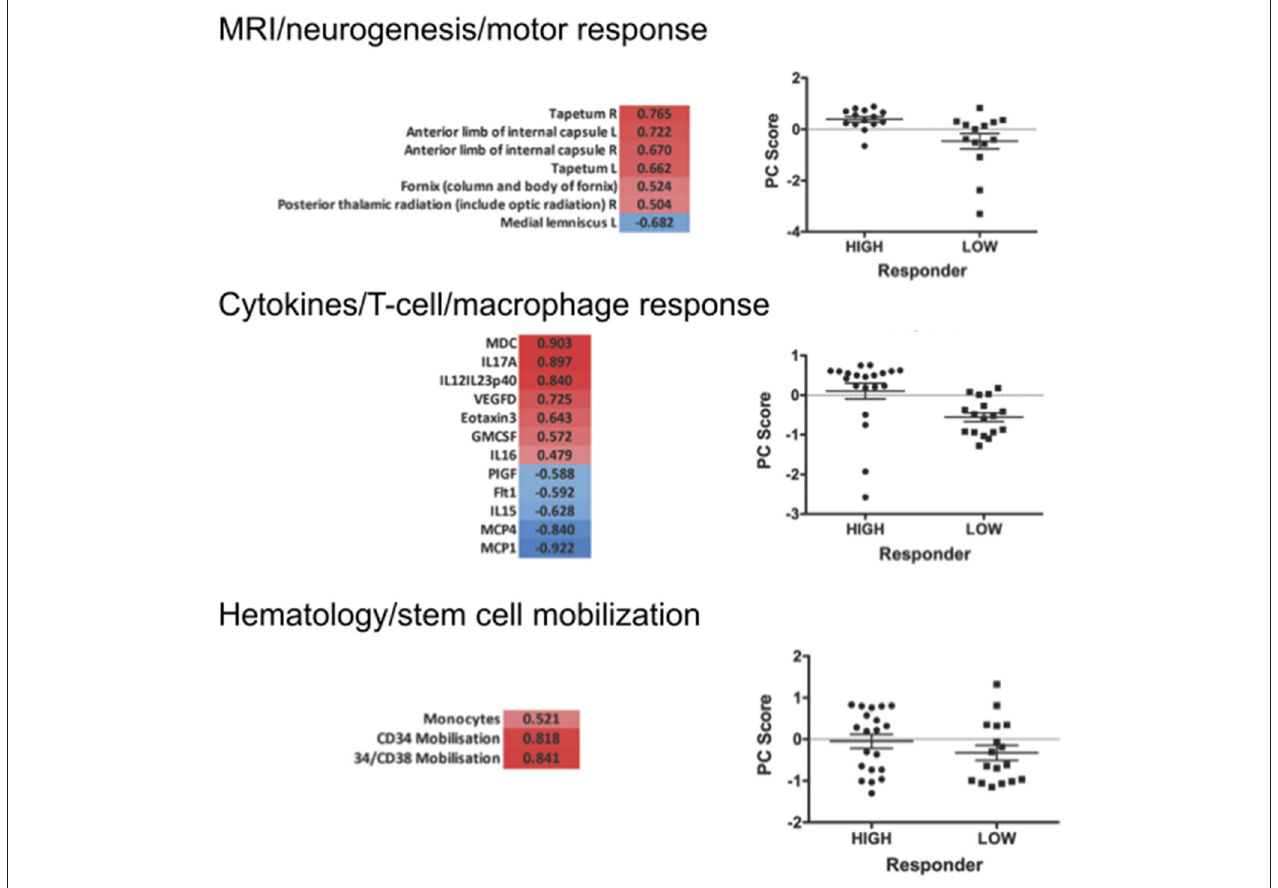
FIGURE 7 | Selected PCA at 12 months of filgrastim treatment. Focusing upon selected non-linear PCA of neuroimaging (neurogenesis and motor response; first part), cytokines (T-cell and macrophage response; second), and hematology (stem cell mobilization; last part) at 12 months of treatment. The PC compounds explaining most of the variance were selected, and only items loading over a threshold of > 0.5 were included to the analysis: PC3 reflecting motor system and neurogenesis was chosen for the imaging evaluation ( p < 0.01); PC1 was selected for the cytokine data—reflecting the T-lymphocyte-macrophage response ( p < 0.01); in hematology PC3 was selected, reflecting stem cell mobilization and monocyte mobilization ( p < 0.01). The graphs give a comparison of scores on the selected PCs in responding vs. non-responding filgrastim patients. PCAs at 3 and 6 months are displayed in Supplementary Material